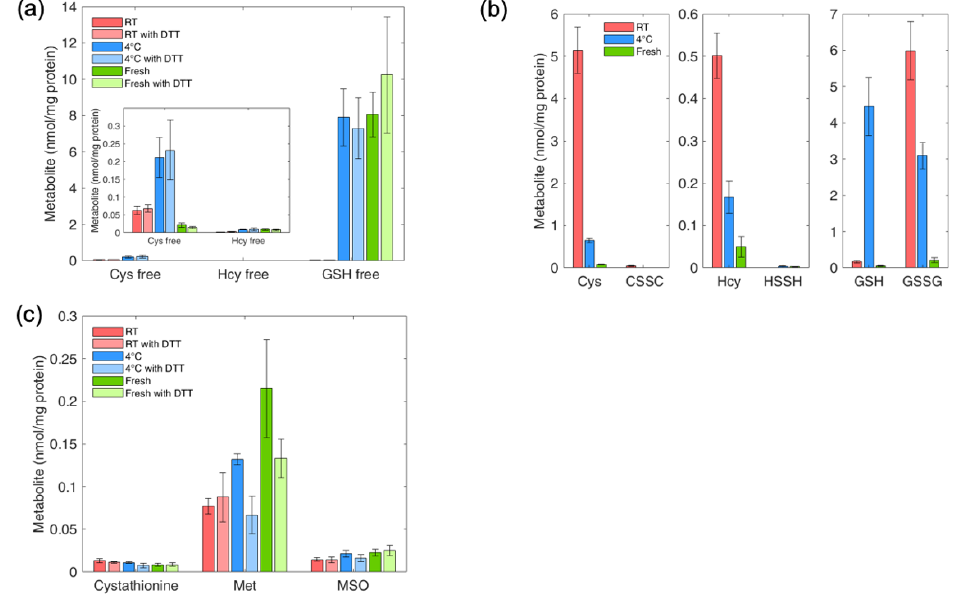
Figure 6. Effect of sample storage conditions on the thiol and thioether metabolite profile of human red blood cells. Blood was drawn from a healthy subject and processed immediately (Fresh) or stored at room temperature (RT) or 4 °C (4 °C) for 16 h for prior to metabolite profiling. Panel ( a ). Pools of free reduced thiols blocked with iodoacetamide, with and without sample treatment with DTT. Panel ( b ). Pools of oxidized and total reduced thiols under the three different sample handling conditions. Panel ( c ). Quantification of thioethers cystathionine, methionine and methionine sulfoxide under the three different sample handling conditions. Values are expressed as the mean ± standard deviation.